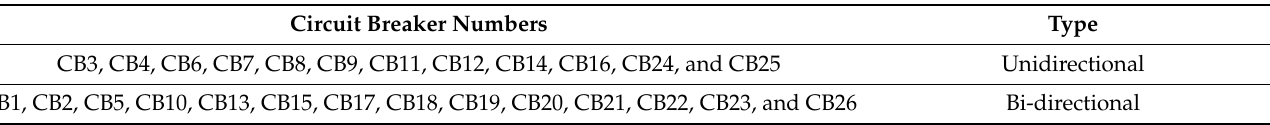
Table 4. Description of the protection scheme circuit breakers.